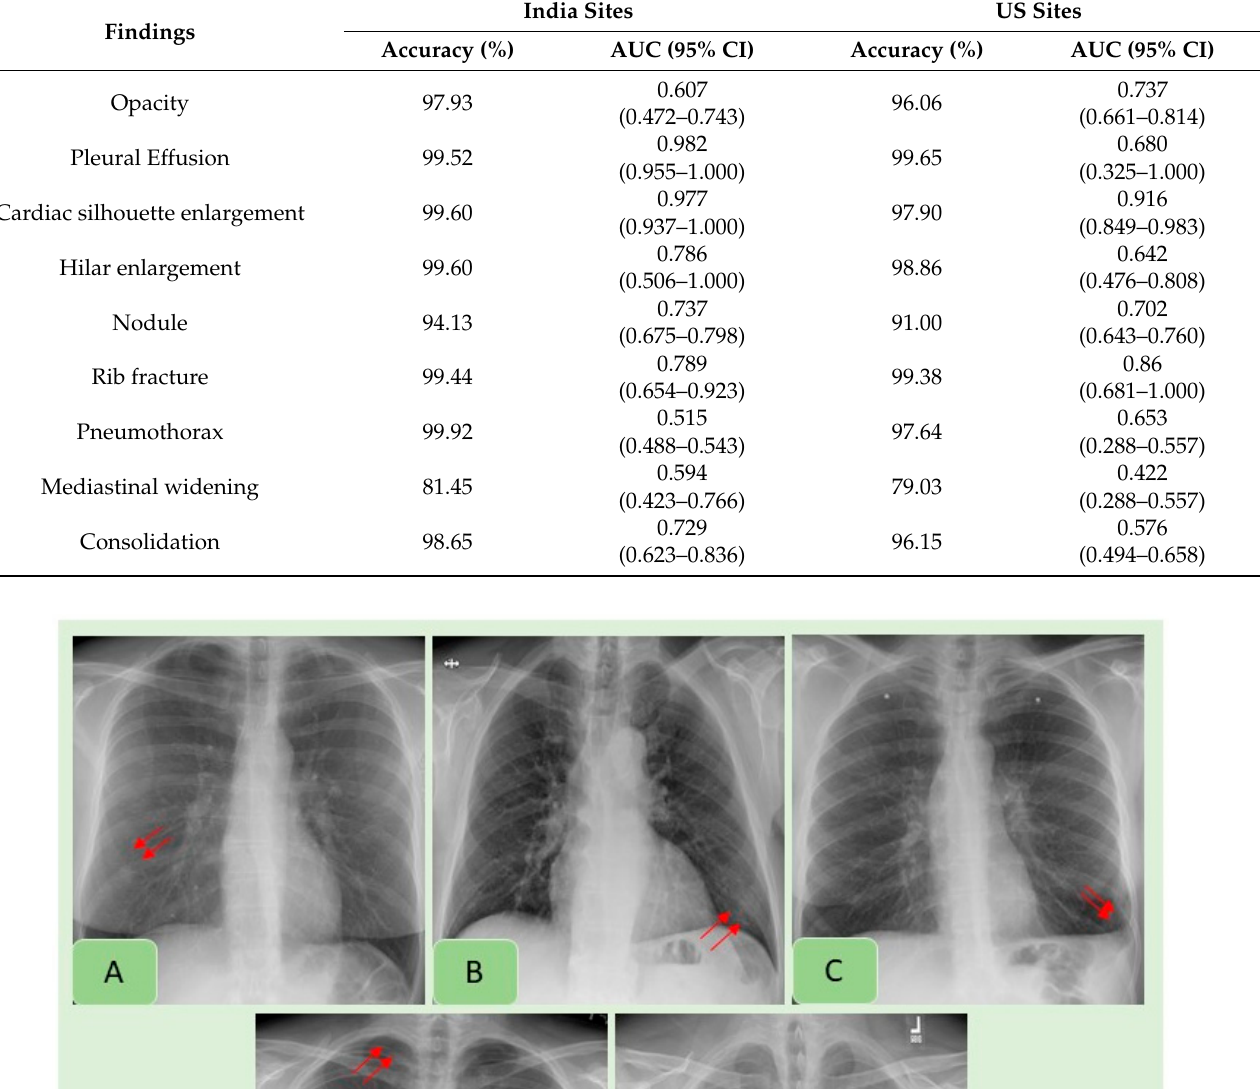
Table 3. Accuracy and area under the curve (AUC) of the AI algorithm based on vendor-based thresholds for different findings on CXRs. The numbers within the parentheses represent 95% confidence intervals.